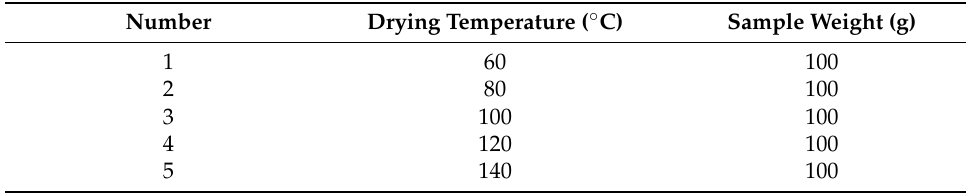
Table 2. Experimental scheme of electrothermal